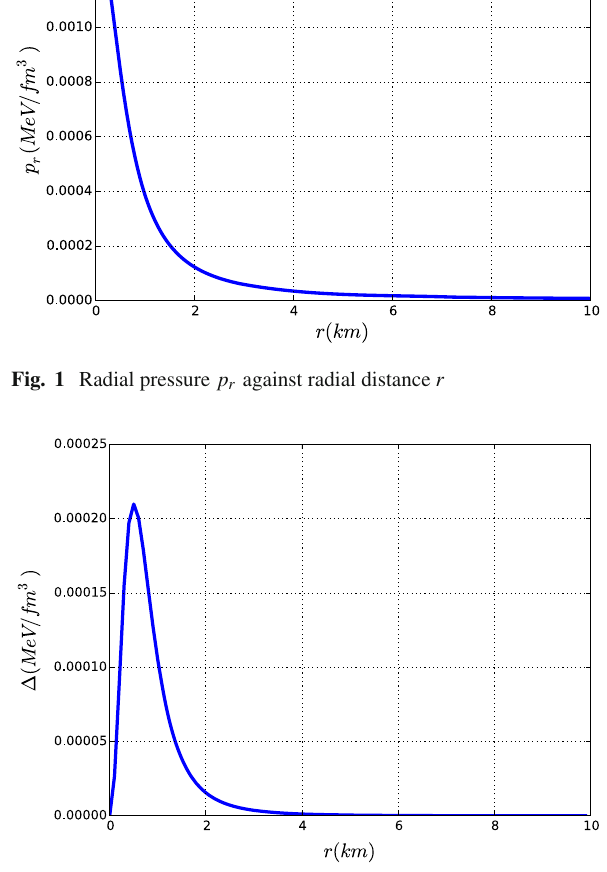
Fig. 2 Pressure anisotropy Δ against radial distance